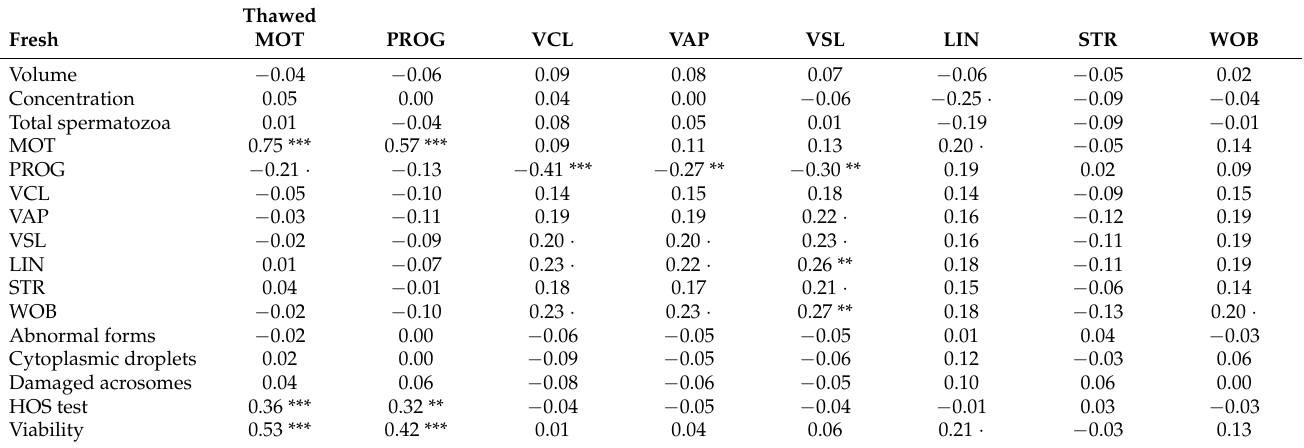
Table 2. Correlation analysis (Pearson r) between fresh and post-thawing parameters for the Asturiana de la Montaña bulls (cont. to Table